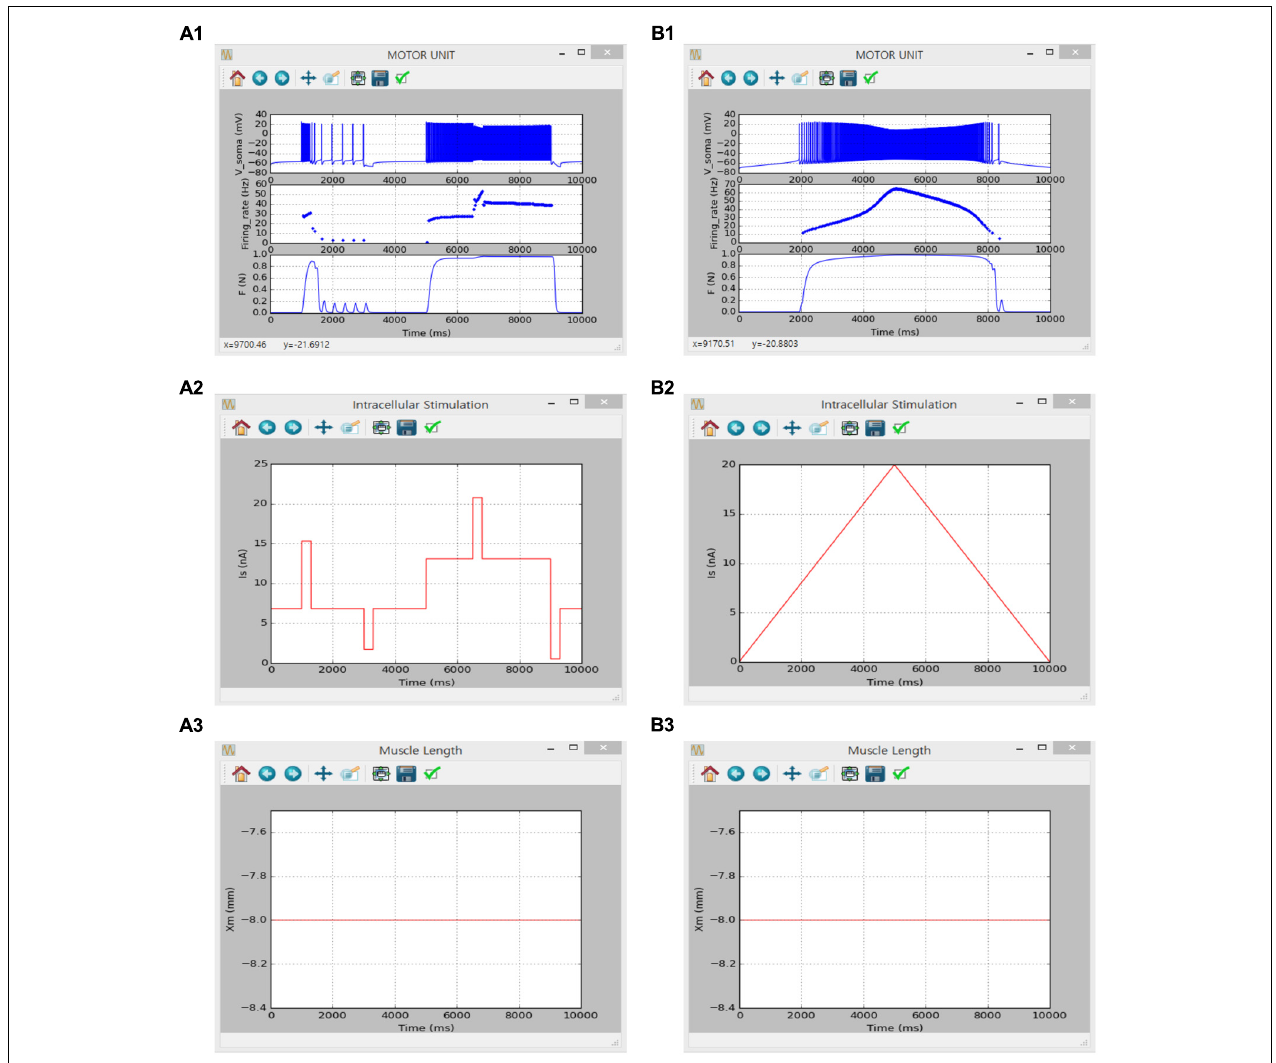
FIGURE 8 | Non-linear input-output behavior of a slow motor unit with I soma . (A1–A3) Voltage responses at the soma (V soma , upper panel in A1 ), instantaneous firing rate (Firing_rate, middle panel in A1 ) and muscle force (F, bottom panel in A1 ) in response to the step current with alternating excitatory and inhibitory pulses injected at the soma (I s , A2 ) at the optimal muscle length (X m , A3 ). (B1–B3) Voltage responses at the soma (V soma , upper panel in B1 ), instantaneous firing rate (Firing_rate, middle panel in B1 ) and muscle force (F, bottom panel in B1 ) against slowly ascending and descending current injections at the soma (I S , B2 ) while maintaining the optimal muscle length (X m , B3